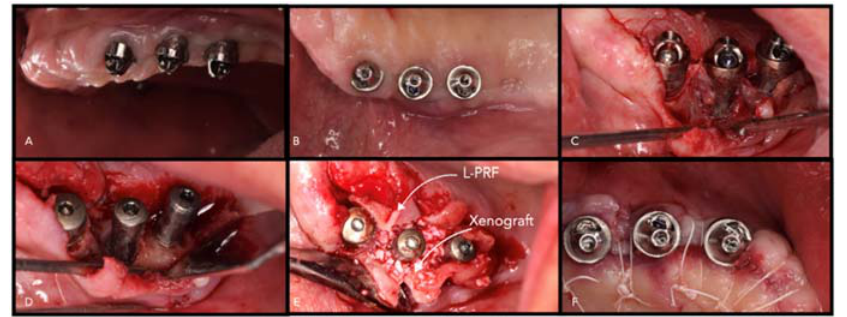
Figure 8. Peri ‐ implant defects treated with L ‐ PRF and xenografts. ( A ) Baseline, ( B ) baseline occlu ‐ Figure 8. Peri-implant defects treated with L-PRF and xenografts. ( A ) Baseline, ( B ) baseline oc- sal view, ( C ) access flap, ( D ) implantoplasty, ( E ) L ‐ PRF membranes and xenografts in the defect, clusal view, ( C ) access flap, ( D ) implantoplasty, ( E ) L-PRF membranes and xenografts in the defect, ( F ) primary wound healing. ( F ) primary wound